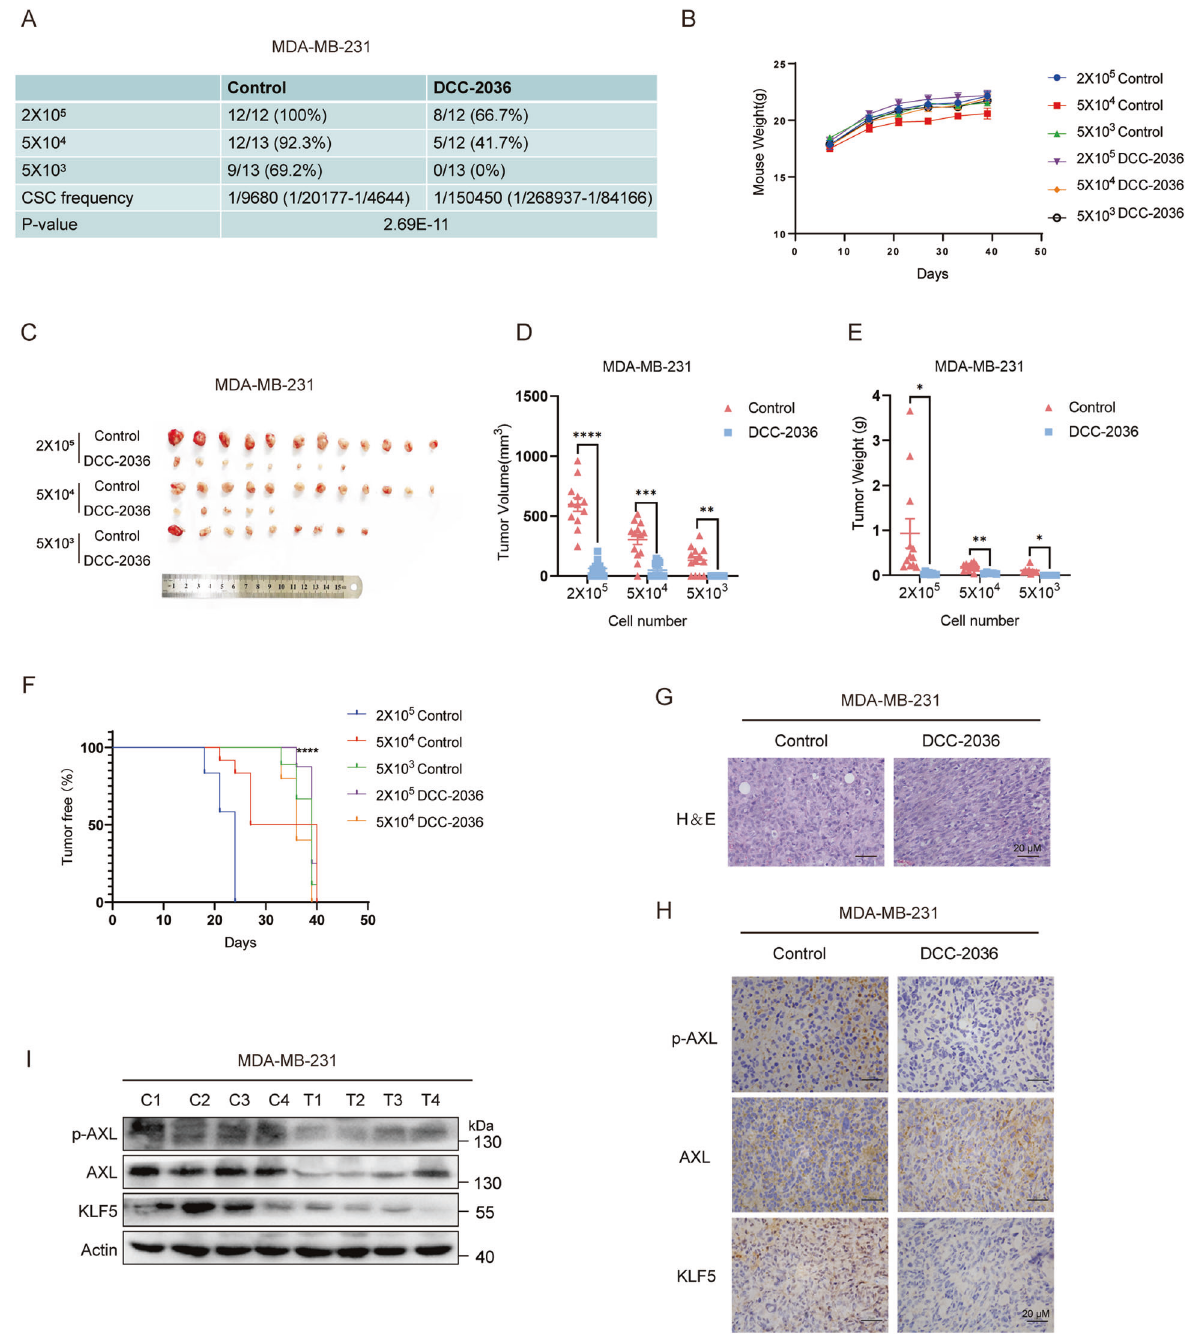
Fig. 6 DCC-2036 inhibits CSCs in vivo according to the limited dilution assay by pretreating MDA-MB-231 cells with DCC-2036 or DMSO for 48 h. A DCC-2036 inhibited tumorigenicity of CSCs in vivo on the basis of the limited dilution assay. MDA-MB-231 cells, treated with DCC- 2036 (5 μ M) or DMSO for 48 h, were transplanted into the mammary fat pad of BALB/C-nude mice in limiting dilutions respectively: 200,000 ( n = 12 and 12), 50,000 ( n = 13 and 12), or 5000 ( n = 13 and 13) cells per injection site. Tumorigenesis was recorded after 1 week. The frequency of breast cancer stem cells (BCSCs) was calculated by ELDA (extreme limiting dilution analysis, http://bioinf.wehi.edu.au/software/ elda/). A statistically signi fi cant difference was detected between groups. B The body weight variation of BALB/C-nude mice over the course of the experiment. C Images of collected tumor xenografts from nude mice at the termination of the experiment. D , E Comparisons of xenograft tumor size and weight between groups at the end of experiments. The statistical signi fi cance was determined by Student ’ s t -test. F The curves showed the probability of tumor-free survival vs days in the nude mice injected with different numbers of MDA-MB-231/control and MDA-MB- 231/DCC-2036 cells. The statistical signi fi cance was determined by a log-rank test. **** P < 0.0001. G The effect of DCC-2036 on the xenograft tissues in BALB/C-nude mice. Hematoxylin and eosin (H&E) staining indicates the histology of tumor tissues. Scale bars, 20 μ m. H Immunohistochemical analysis using p-AXL, AXL, and KLF5 antibodies in xenograft tissues from BALB/C-nude mice. Scale bars, 20 μ m. I Immunoblot of xenograft tissues from BALB/C-nude mice posterior to the experiments. C means Control, T means DCC-2036. We chose the tumor tissues randomly for H&E staining, immunohistochemical analysis, and immunoblotting.